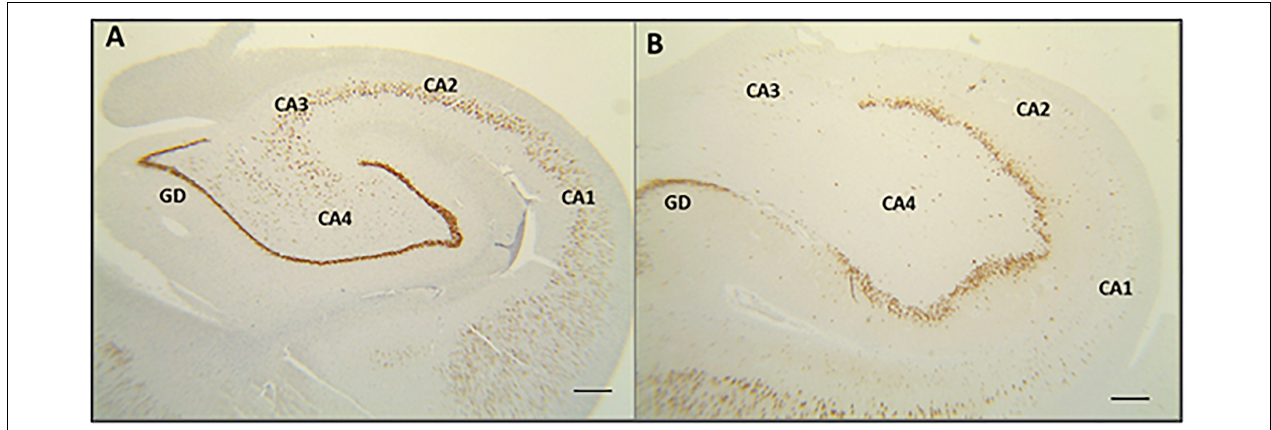
FIGURE 1 | Image of hippocampal tissue comparing specimens from healthy control and a patient with temporal lobe epilepsy associated with hippocampal sclerosis (MTLE-HS). (A) Normal hippocampal neuronal density, as well as sectors delimitations (from CA1 to CA4), obtained from a healthy individual (NeuN staining and 2x objective magnification). (B) Reduction of the hippocampal neuronal density in a patient with MTLE-HS. There was no histopathological difference in neuronal densities between MTLE-HS patients with and without comorbid depression.